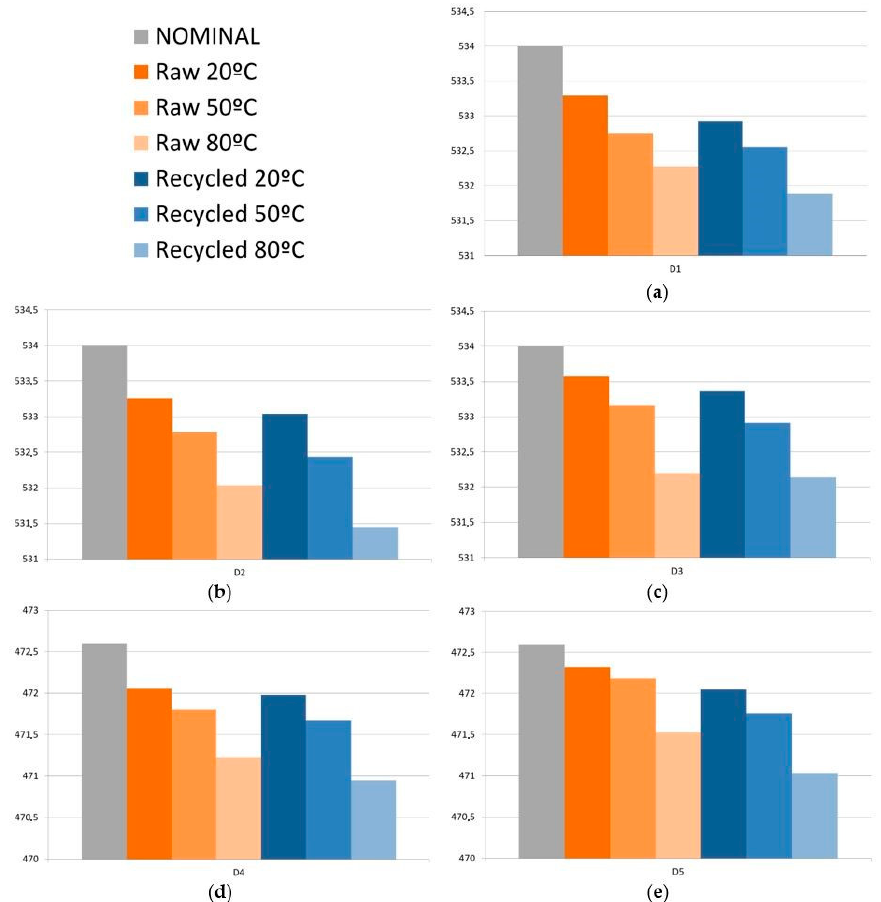
Figure 5. Di measurements (mm) at different environmental conditions for raw and recycled material, ( a ) D1; ( b ) D2; ( c ) D3; ( d ) D4; ( e ) D5. ( a ) D1; ( b ) D2; ( c ) D3; ( d ) D4; ( e )